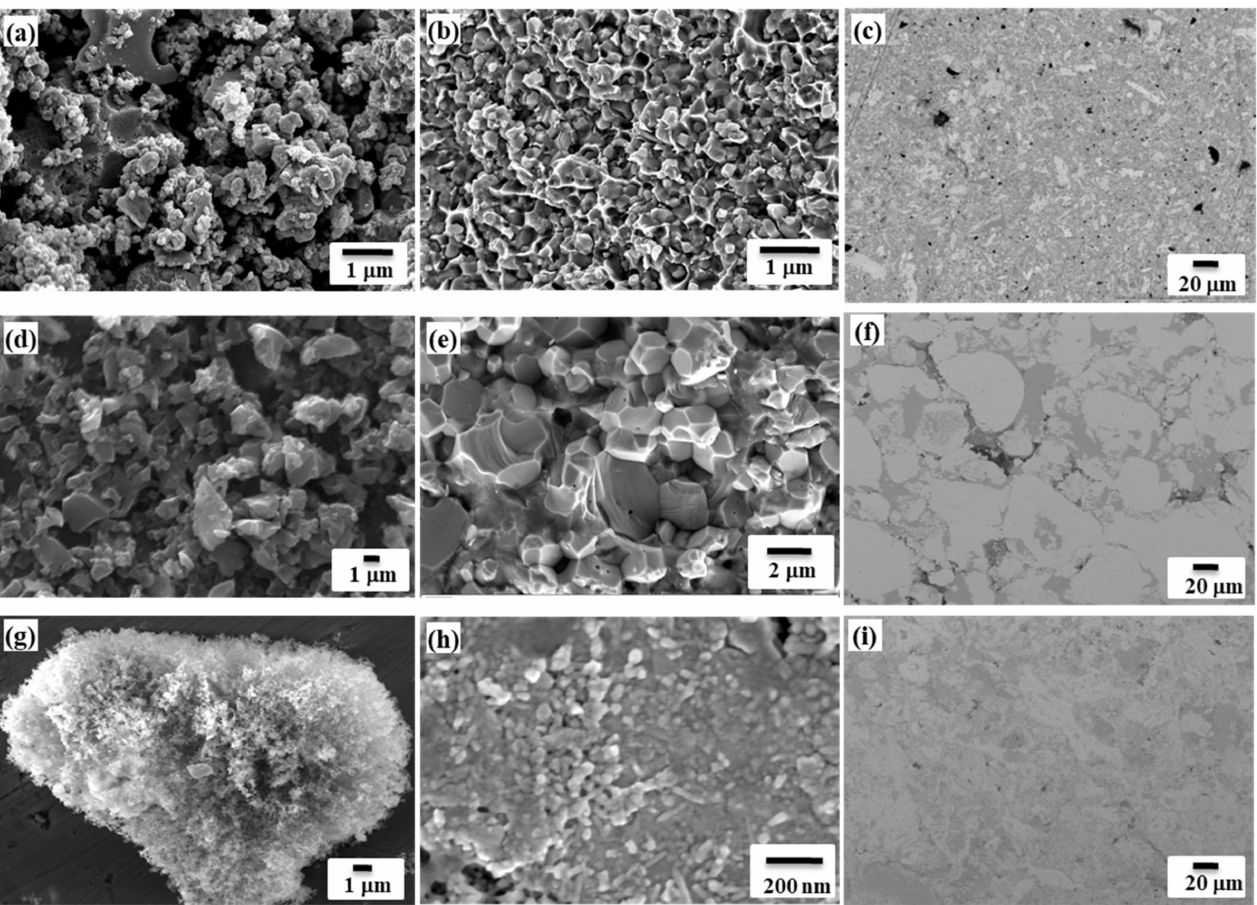
Figure 8. SEM of Mo-Cu powders obtained by different pathways ( a , d , g ); SEM images after SPS of samples fracture and surface of Cu-Mo obtained from SHS + SCS pathway ( b , c ); Cu-Mo obtained from SHS of oxides ( e , f ); Cu-Mo obtained from SHS of CuMoO 4 salt ( h , i ); T = 950 ◦ C, P = 100 MPa, t = 6 min, d = 10